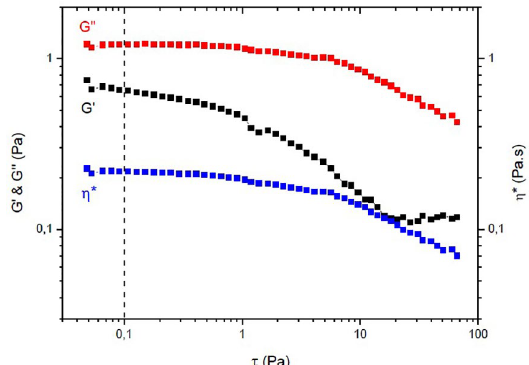
Figure 1. Dynamic stress sweep test of the uncrosslinked chitosan